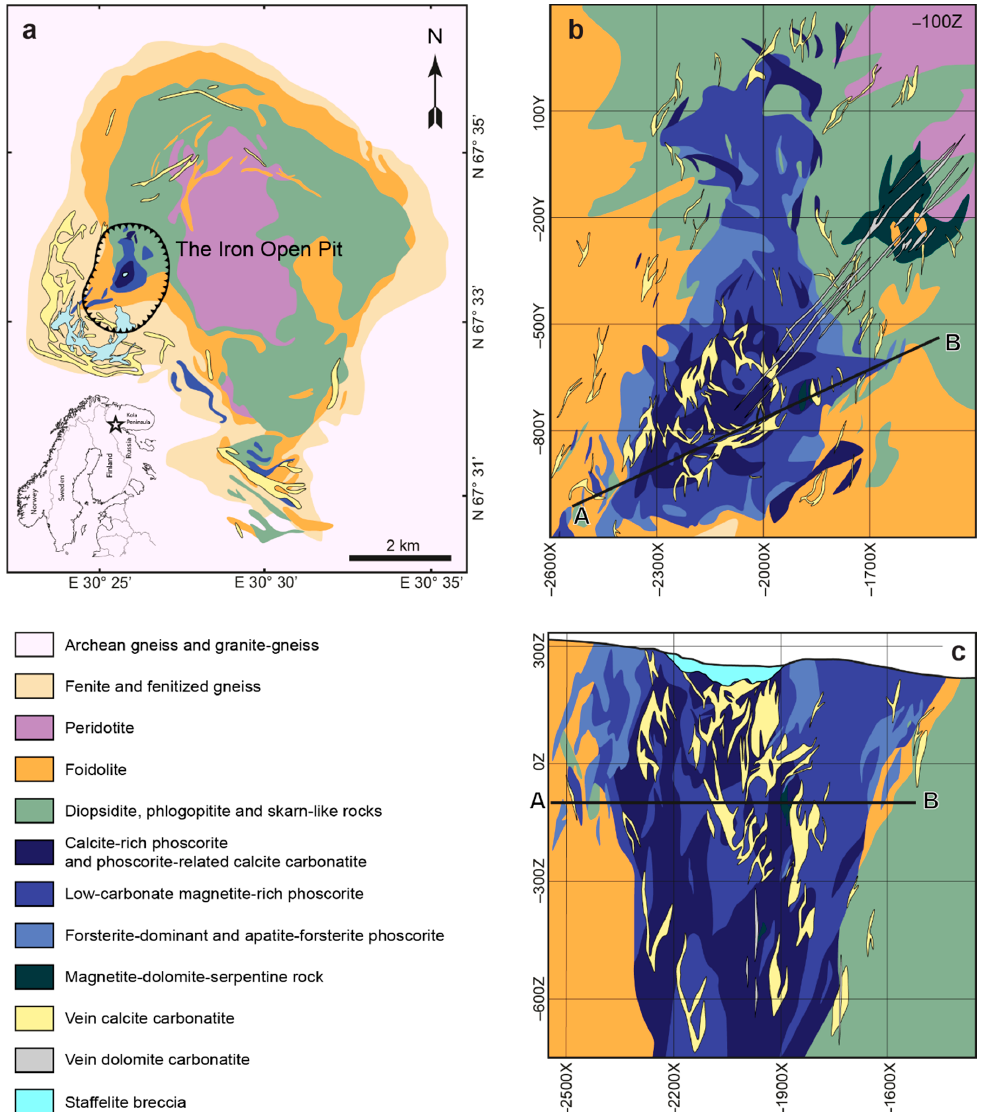
Figure 1. ( a ) Geological map of the Kovdor alkaline-ultrabasic massif, after Afanasyev and Pan’shin, modified after [9]; cross-sections of the Kovdor phoscorite-carbonatite complex: ( b ) horizontal ( − 100 m, Y axis shows the North) and ( c ) vertical along A-B line, after [11]. At the western contact of peridotite and foidolite, there is a concentrically zoned pipe of phoscorite and carbonatites (Figure 1b,c) highly enriched in magnetite, hydroxylapatite and